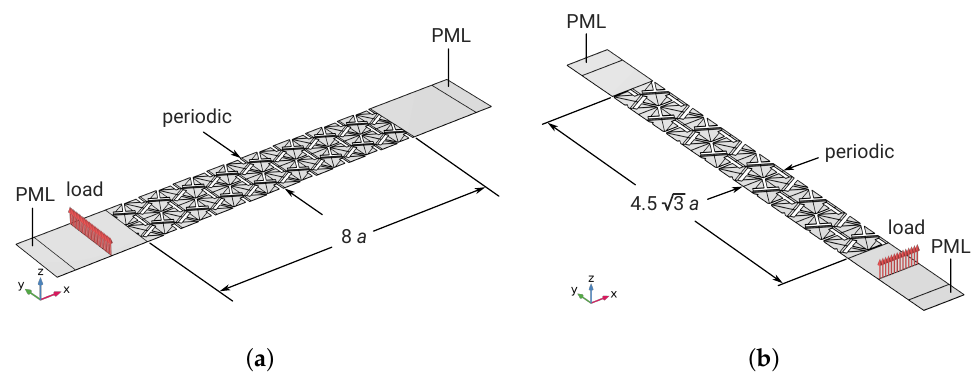
Figure 11. Finite-element models for the metamaterial transmission loss numerical